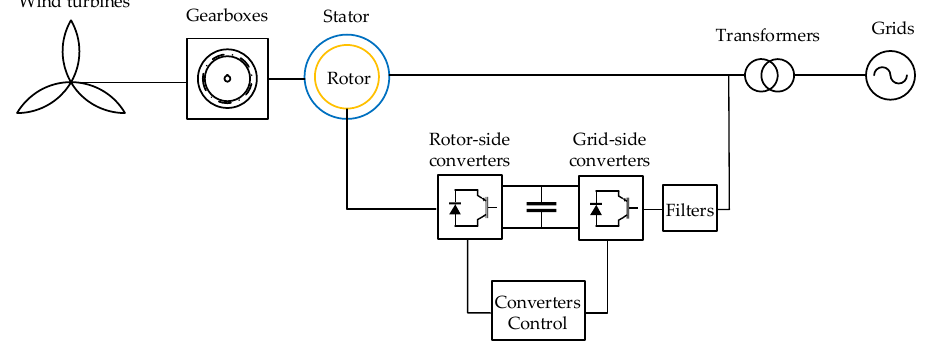
Figure 1. Doubly ‐ fed wind turbine structure. Figure 1. Doubly-fed wind turbine